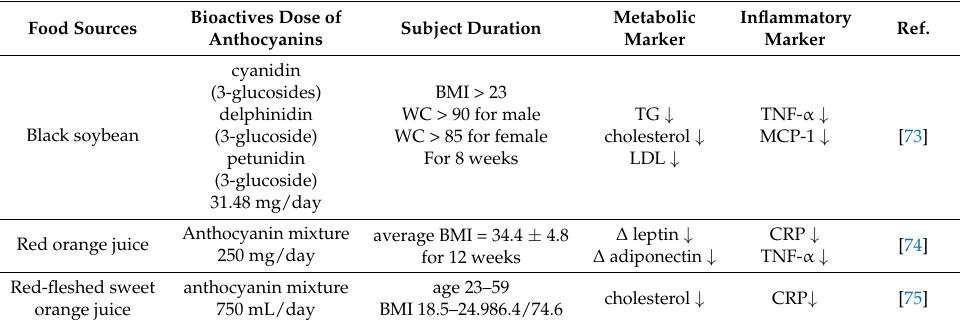
Table 3. Effects of dietary anthocyanins on obesity and inflammation (clinical study).